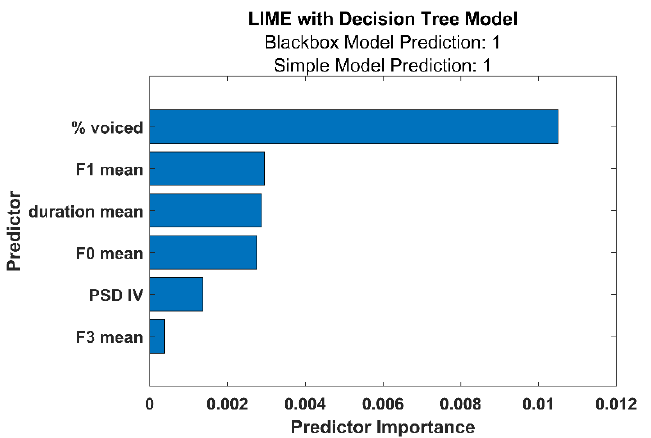
Figure 1. LIME MATLAB output: weights of the acoustical parameters for a specific observation.